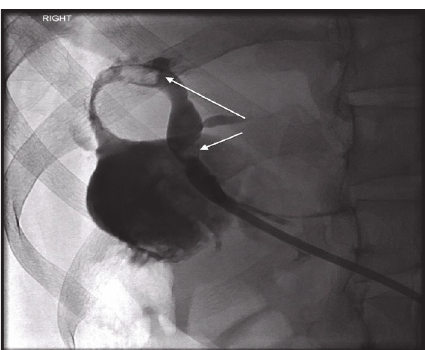
Figure 1: Cholangiogram demonstrating filling defects representa- tive of biliary stones (arrows) present in the common bile